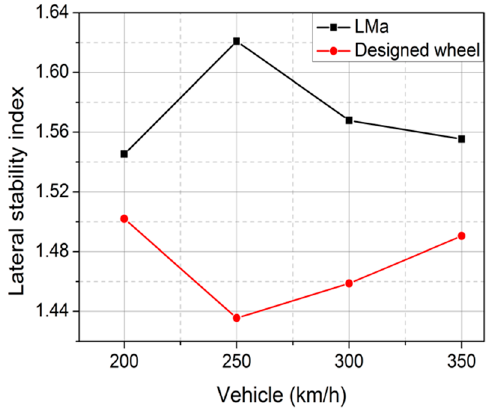
Figure 23. Lateral stability index.